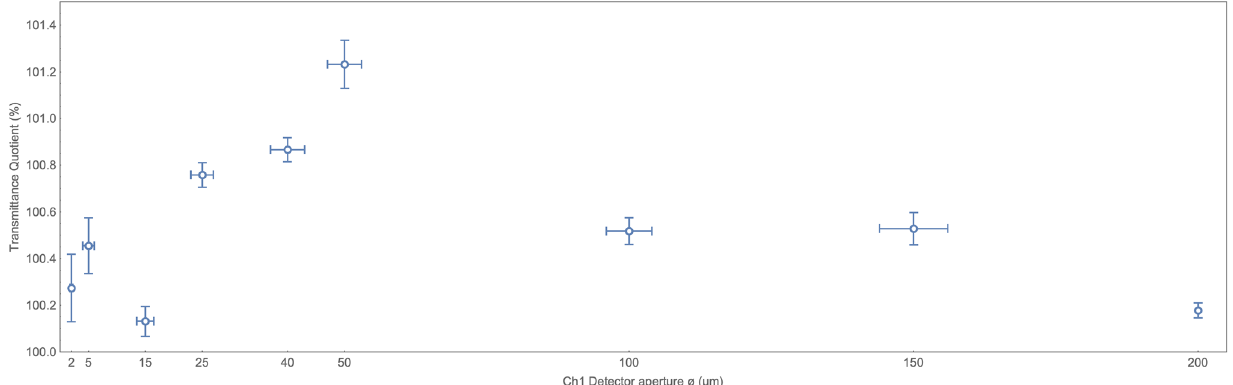
Figure 7. The aggregated results of the experiment: mean transmittance quotients TQ along with their 1 σ standard errors (vertical bars) and aperture tolerances (horizontal bars). The transmittance quotients are averaged for all pressures for each examined aperture. The rightmost point is the result of no aperture runs. Quotient greater than 100% means that transmittance measured by the smaller ( < 200 µ m ) Ch 1 detector is higher than transmittance measured by the bigger ( 200 µ m ) Ch 2 detector, which is the case for each